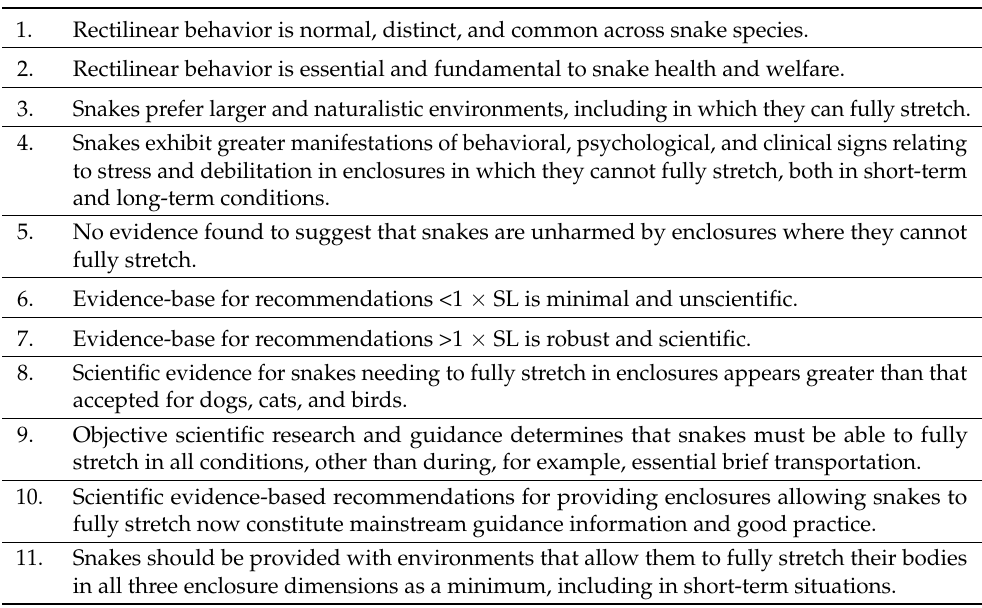
Table 7. Summary highlight conclusions and recommendations regarding snake rectilinear (straight line/stretched out) behavior and enclosure requirements based on peer-reviewed